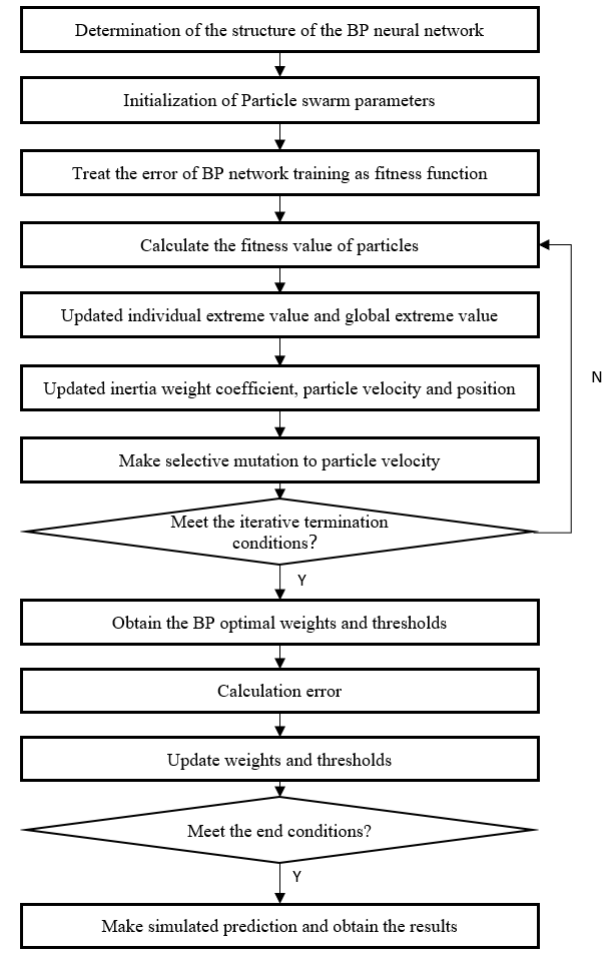
Figure 6. Prediction algorithm map of spare parts consumption based on the IPSO-BP neural net- work. 208